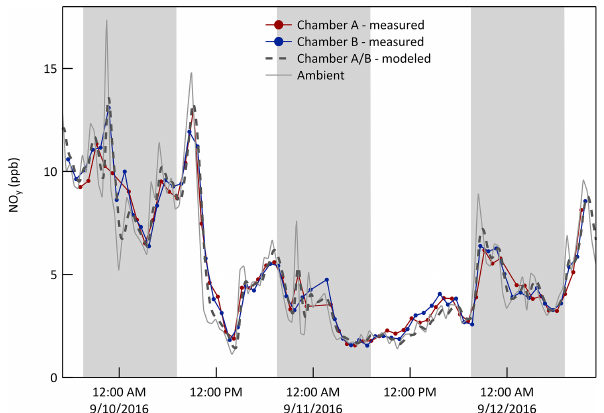
Figure 5. Time series of NO y mixing ratio (ppb) measured in both chambers, measured just outside of them, and calculated from the ambient time series by modeling them as CSTRs with an exchange flow rate, Q ex , of 33Lmin − 1 . The shaded bands represent night-